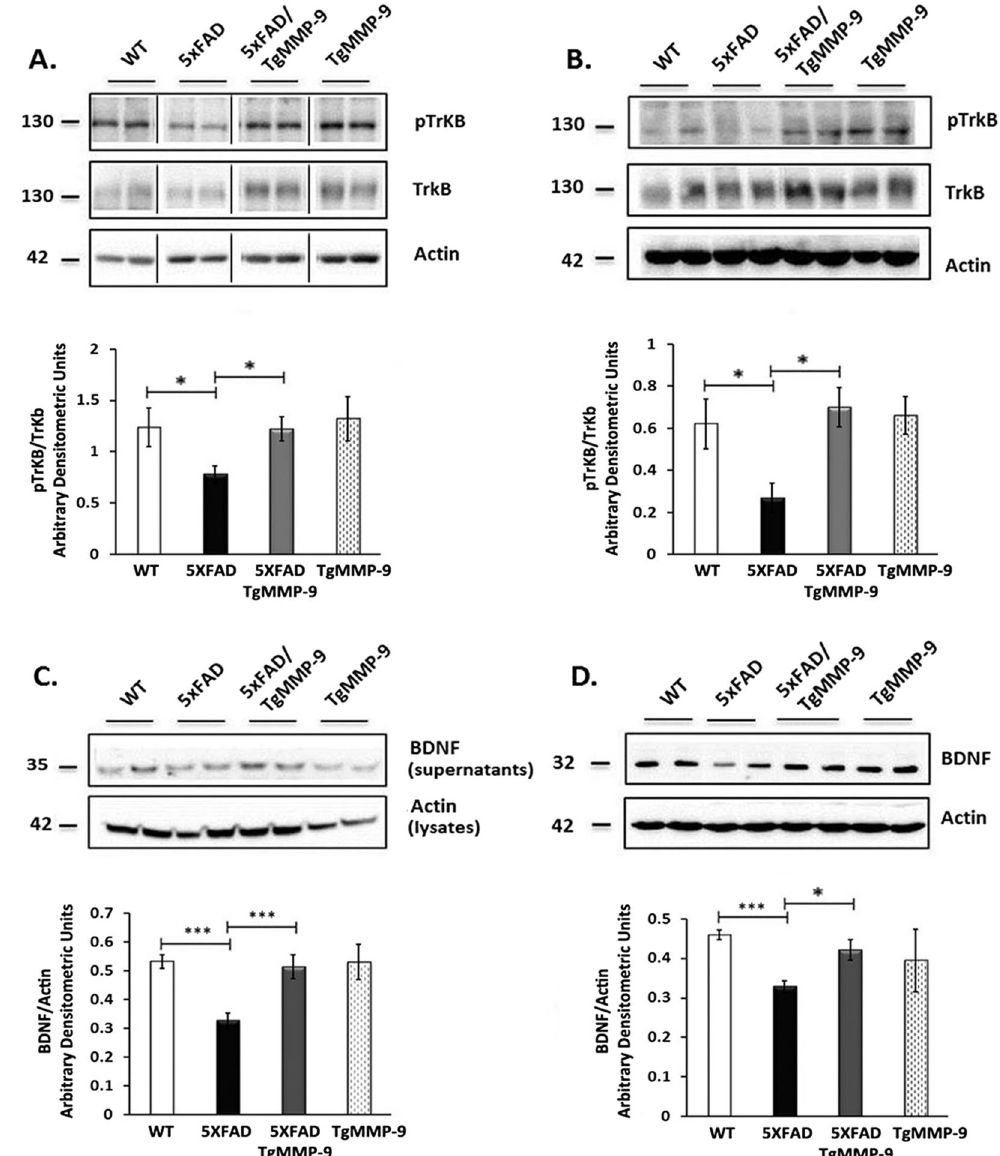
Figure 4. Representative Western blots of protein samples from primary hippocampal cultures ( A , C ) and hippocampal homogenates from 3 month-old mice ( B , D ) of WT, 5XFAD, 5XFAD/TgMMP-9 and TgMMP-9 mice. Equal amounts of total protein were analysed on 7.5% SDS-PAGE gels and immunoblotted with primary antibodies against pTrkB and TrkB ( A,B ). Equal amounts of total protein from hippocampal soluble fractions from 3 month-old mice and primary cell supernatants were analysed on 16% SDS-PAGE gels and immunoblotted against BDNF ( C , D ). Graphs depict densitometric quantification of phosphorylated proteins normalized to their respective total protein levels. To ensure equal loading, membranes were re-probed against β -Actin. n = 4–6 ( A ), n = 5–6 ( C ), n = 3 ( B ), n = 4 ( D ). BDNF levels from primary supernatants were corrected against actin from their respective cell lysates. All data are presented as mean ± SEM ( * p < 0.05, *** p < 0.001). Lanes were run on the same gel but were noncontiguous. Full-length images are presented in the Supplementary